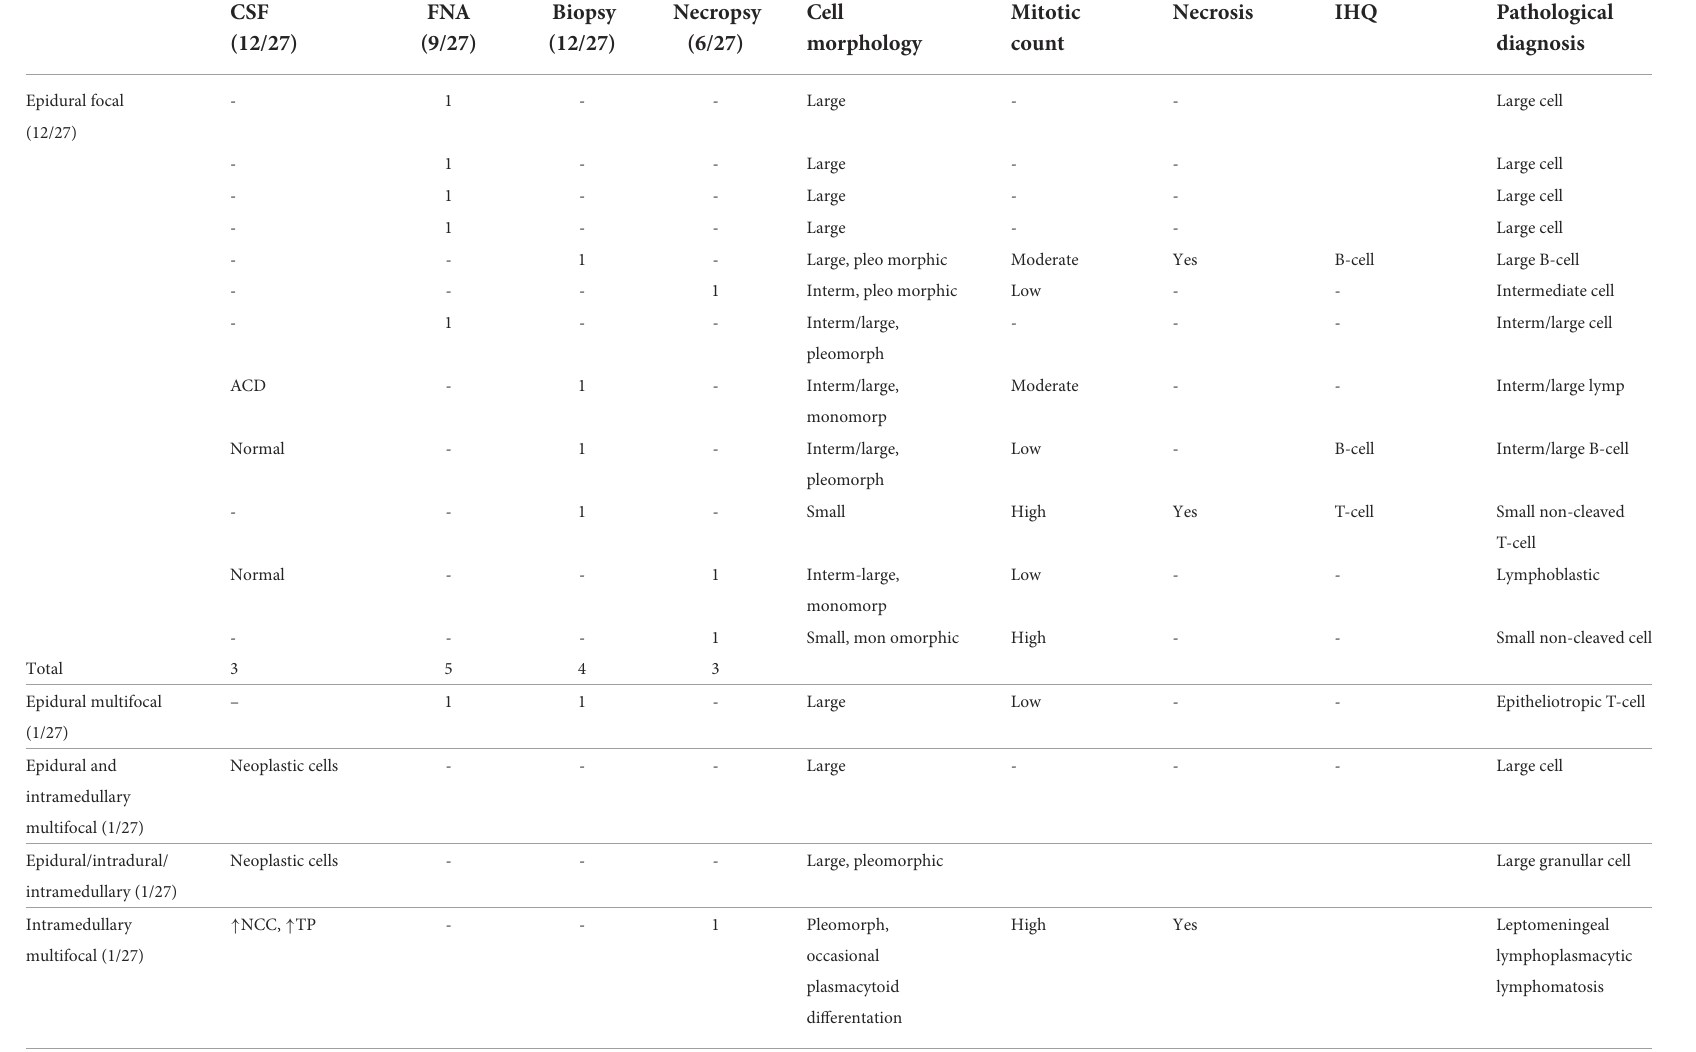
TABLE 4 Results of CSF analysis and cytopathological studies in 27 cats with spinal